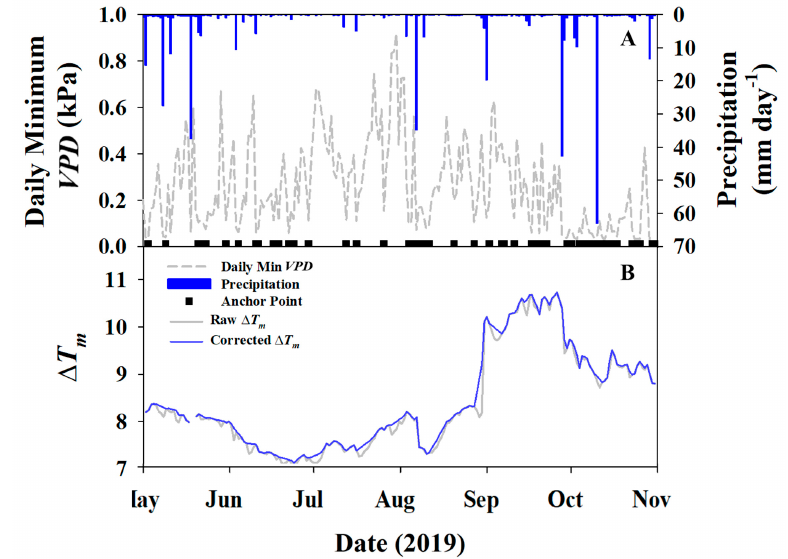
Figure 1. ( A ) Daily minimum vapor pressure deficit (dashed lines) and precipitation (blue bars) with days having a true ∆ T m marked (black squares); ( B ) the raw measured average ∆ T m and corrected ∆ T m portraying baseline smoothing.